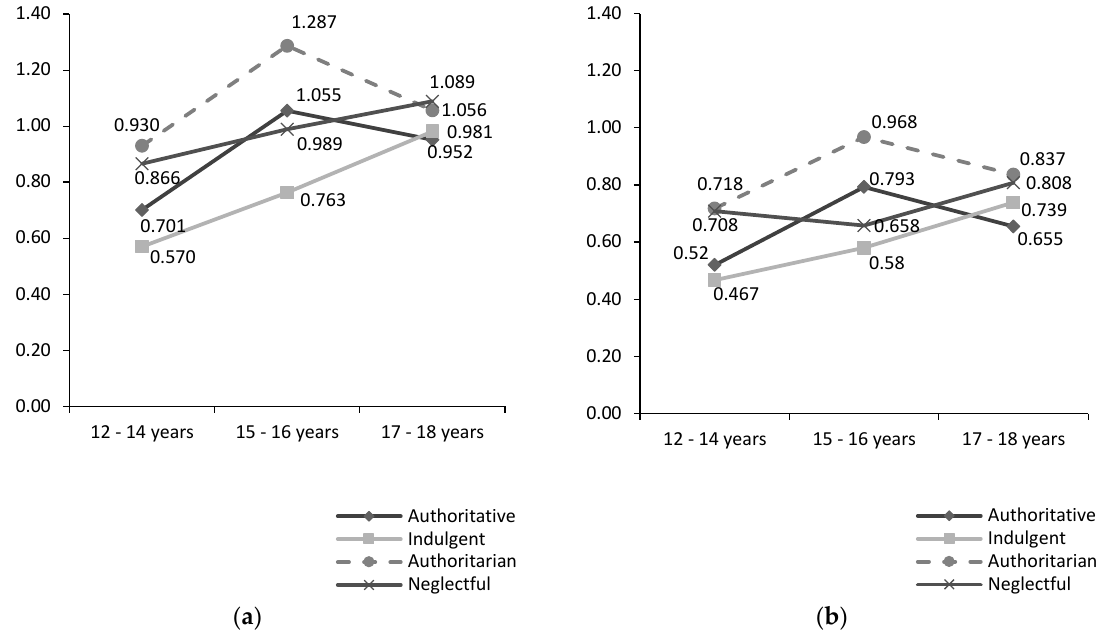
Figure 1. Means of parenting styles by age for verbal aggression against mother ( a ) and father ( b ).